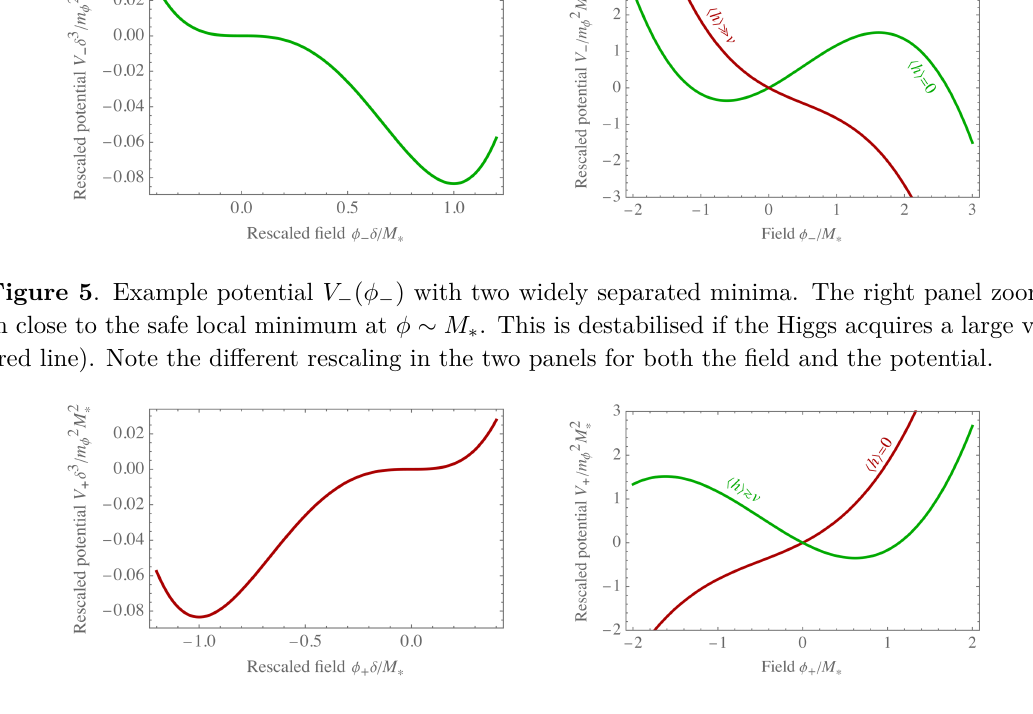
Figure 6 . Example potential V + ( φ + ) , that selects a nonzero Higgs vev. The right panel zooms in close to the safe local minimum at φ + ∼ M ∗ , present only if the Higgs acquires a sufficiently large vev (green